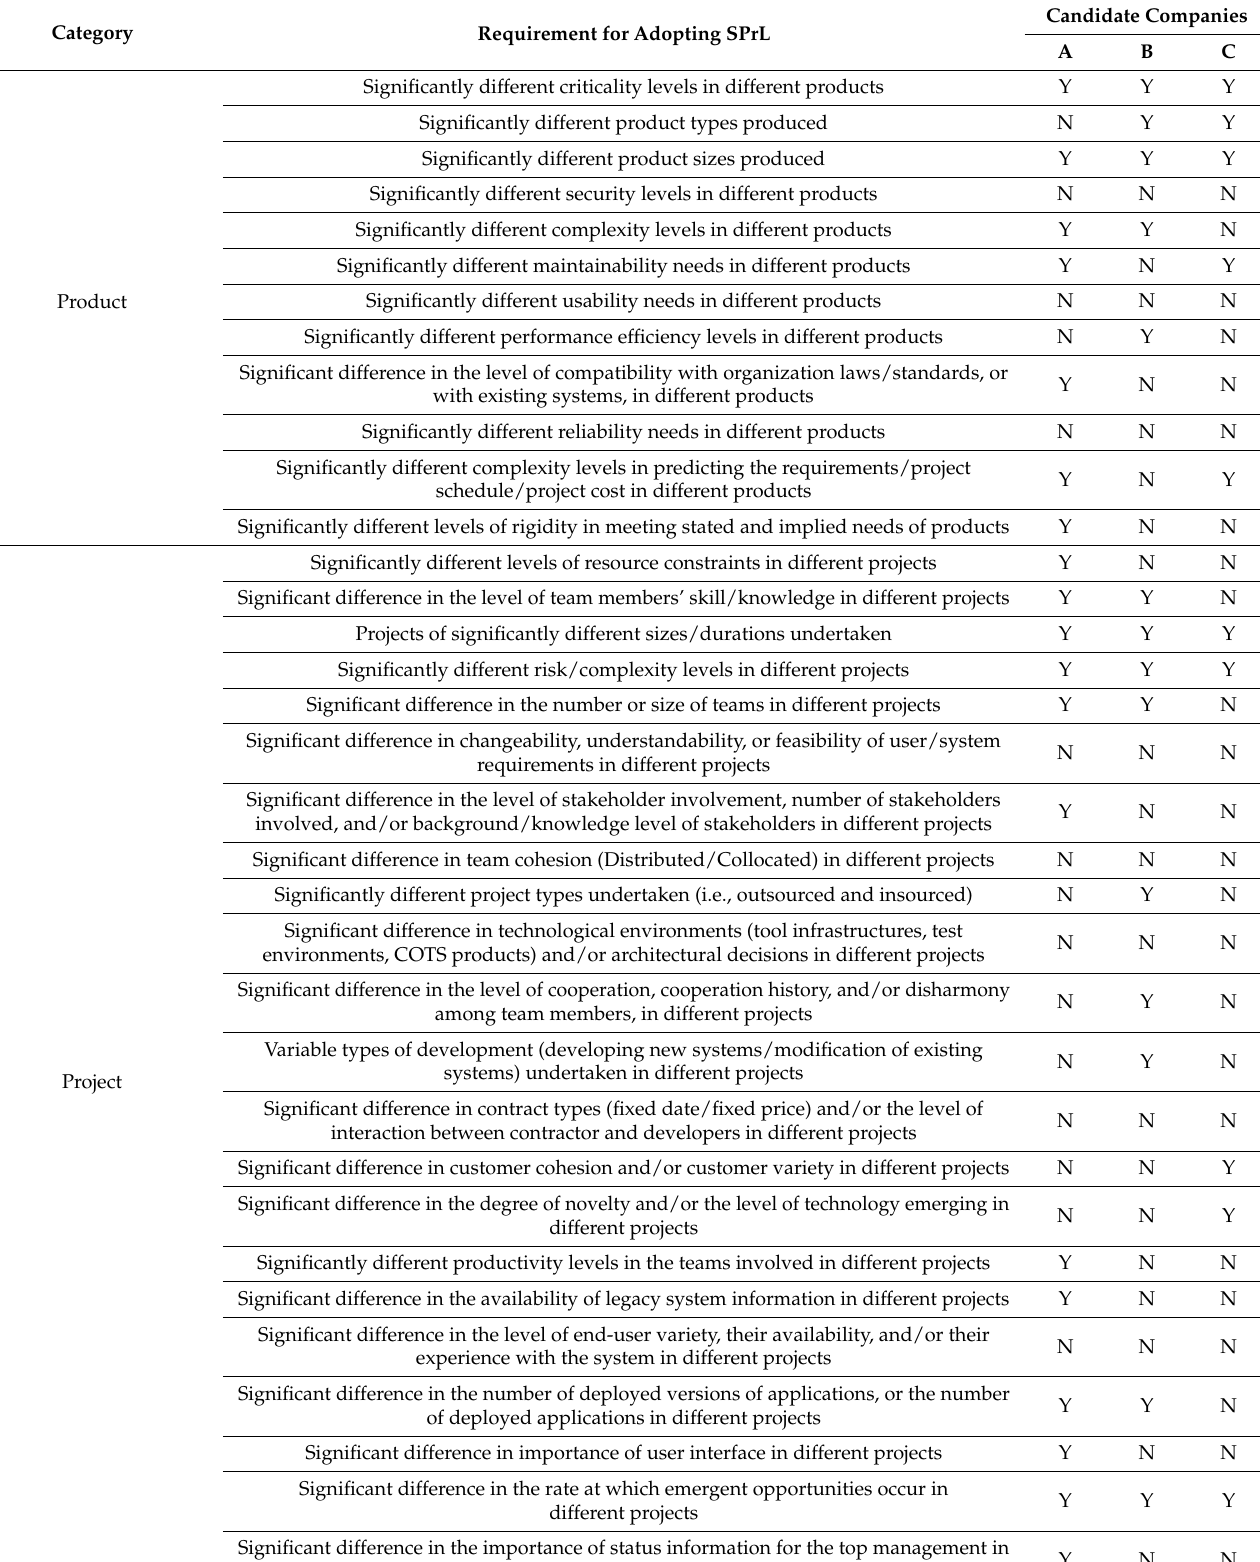
Table A4. Feasibility analysis questionnaire filled out by three